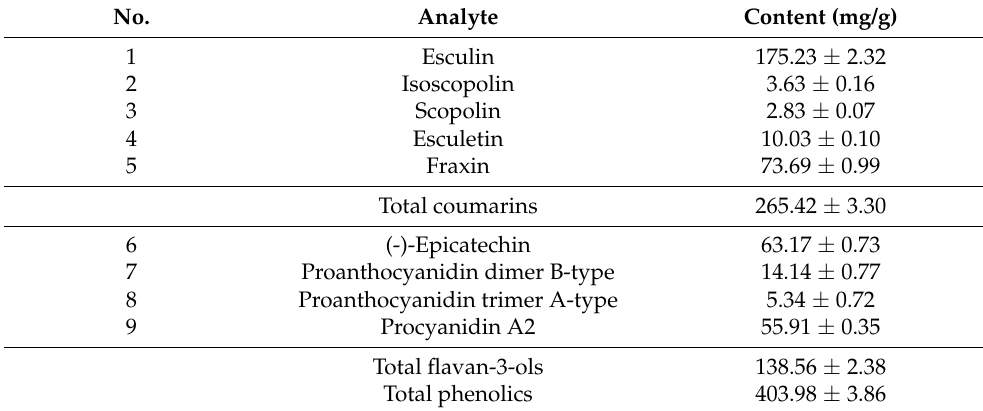
Table 1. Content of individual constituents in the dry methanol extract from the bark of A. hippocastanum .